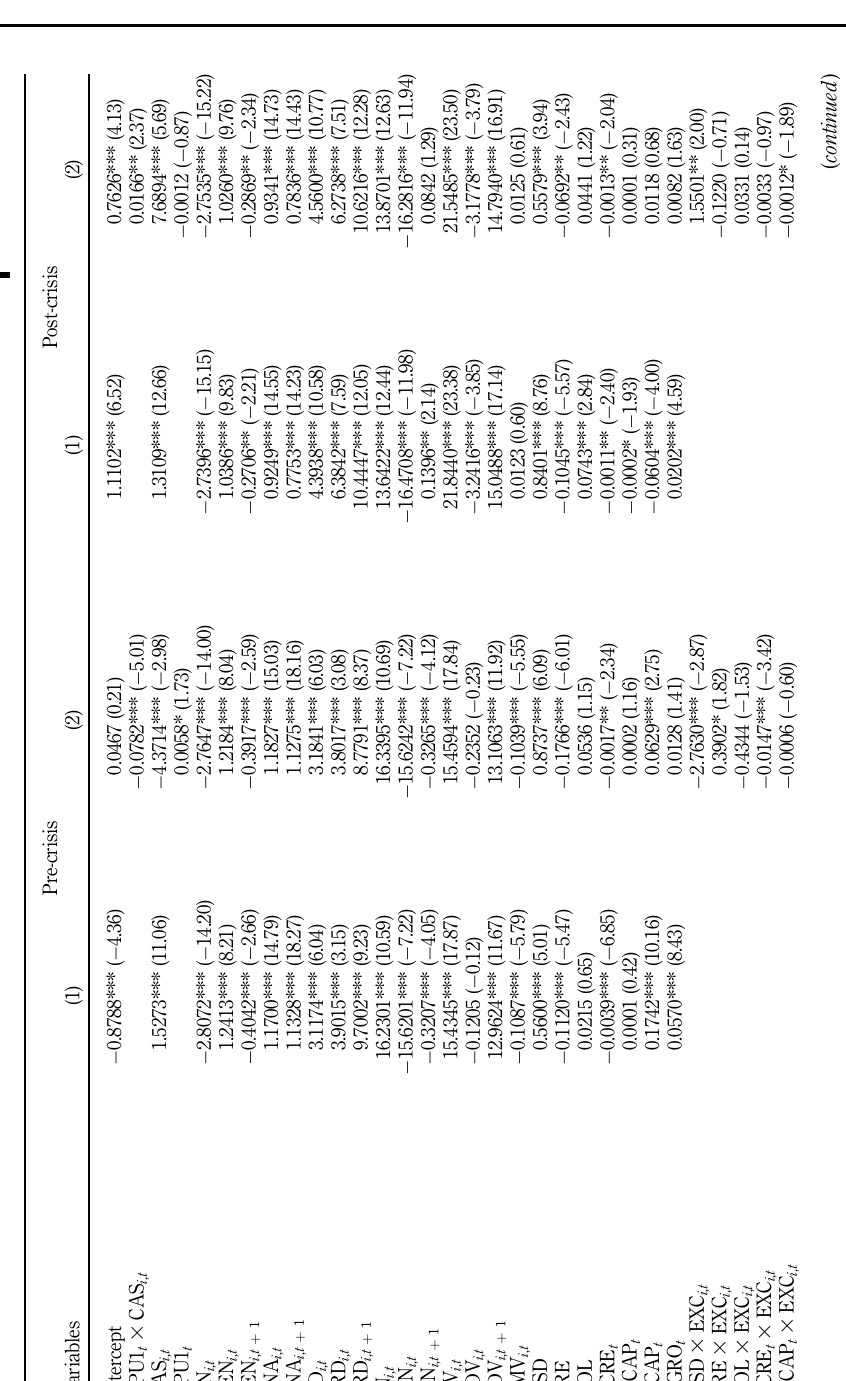
Table 4. Robustness checks with cash